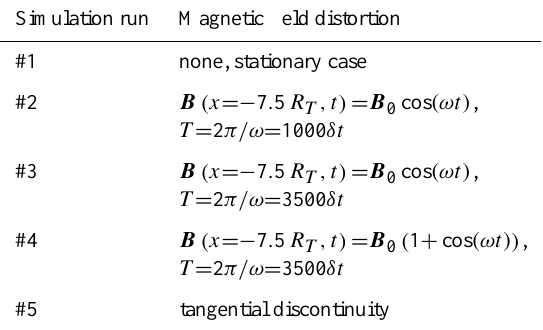
Table 1. Overview of the discussed simulation scenarios. The time step δt of the simulations has been chosen in such way that 1333 δt correspond to one passage of the plasma through the entire simula- tion domain from x =− 7 . 5 R T to x =+ 7 . 5 R T , i.e. δt = 0 . 24 s. As discussed in the text, this is significantly smaller than the gyroperi- ods of the involved pick-up